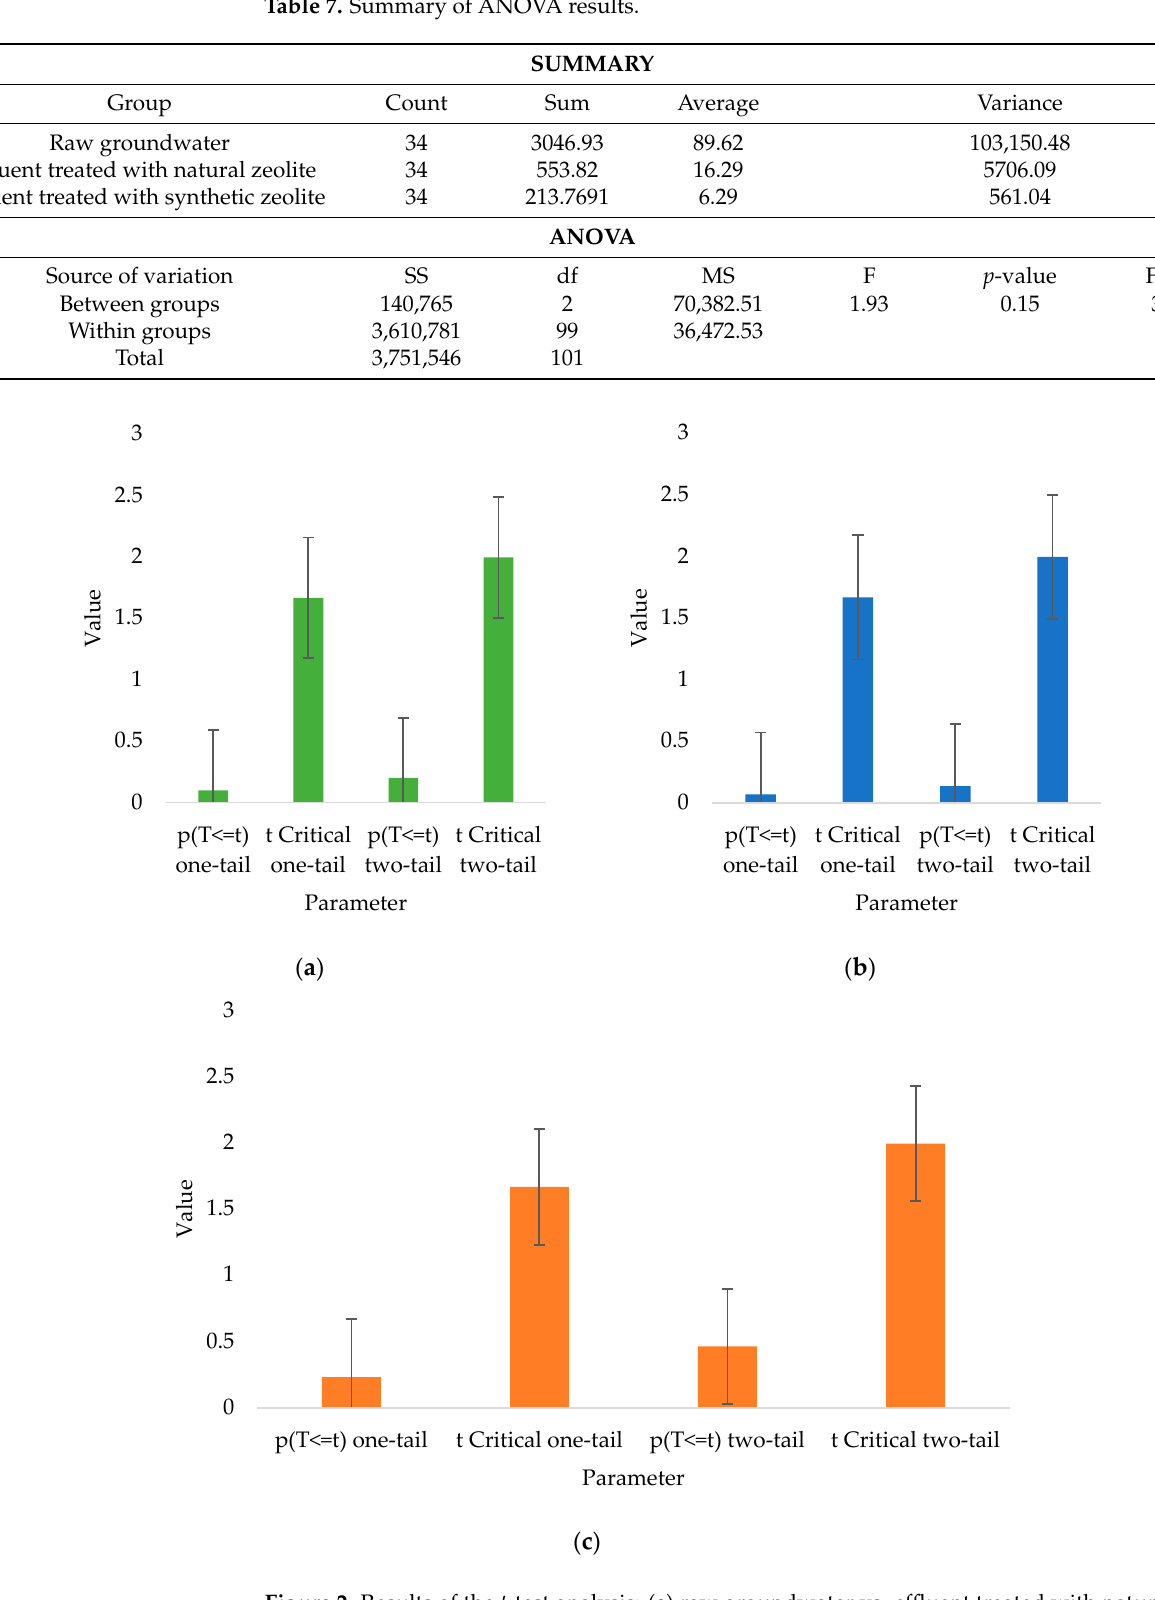
Table 7. Summary of ANOVA results.